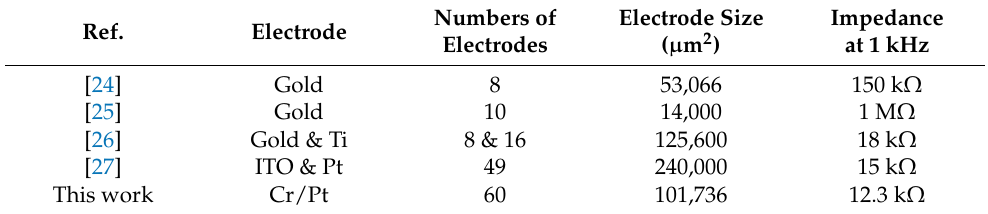
Table 1. Performance comparison of the proposed microelectrode arrays (MEAs) with several reported MEAs.